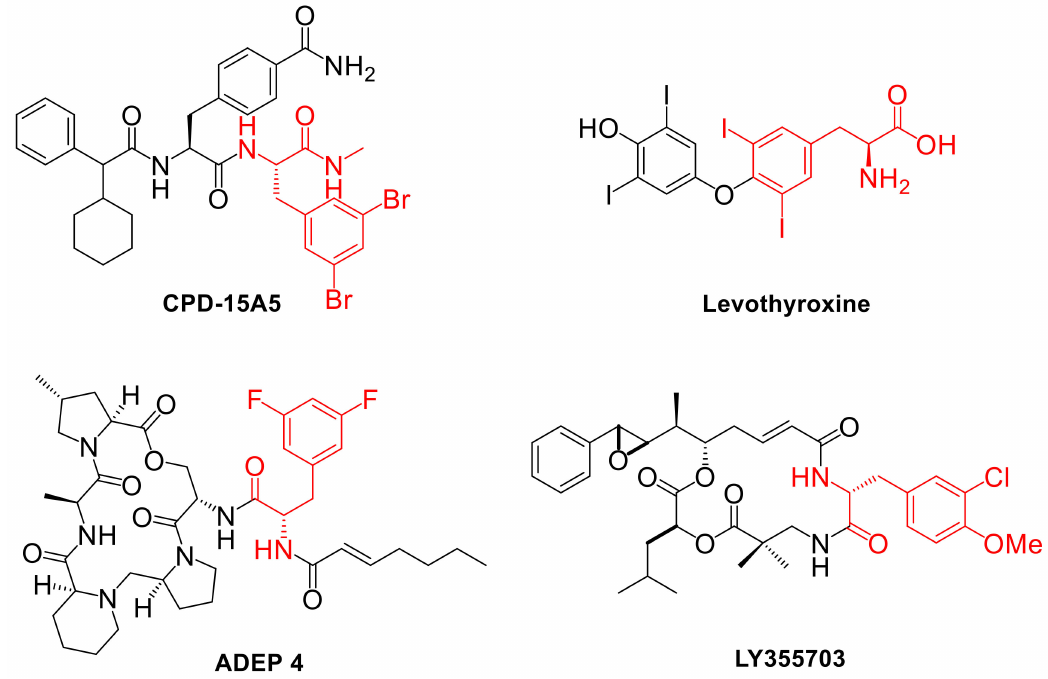
Figure 1. Chemical structures of some biologically active molecules containing α -phenylalanine